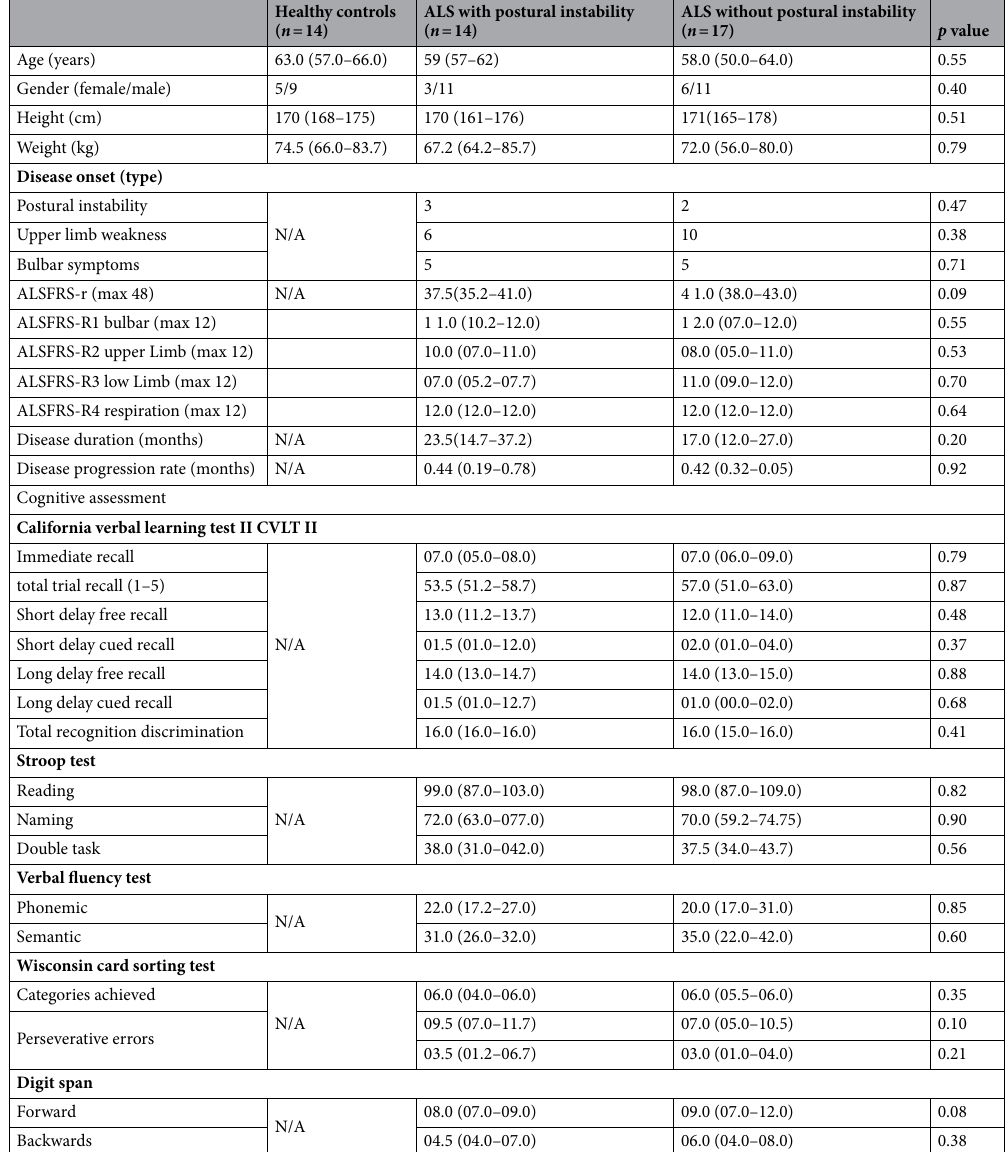
Table 1. The demographic and clinical profile of study participants. Values presented as median (range) for functional scores followed by the minimum and the maximum values. ALSFRS-r: The revised ALS